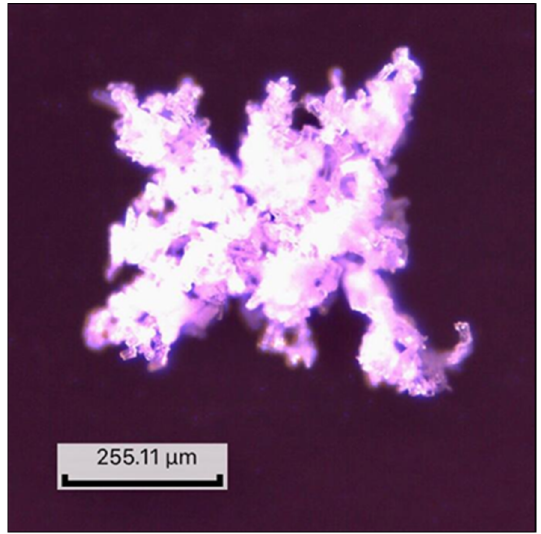
Figure 4. AMH micrograph.